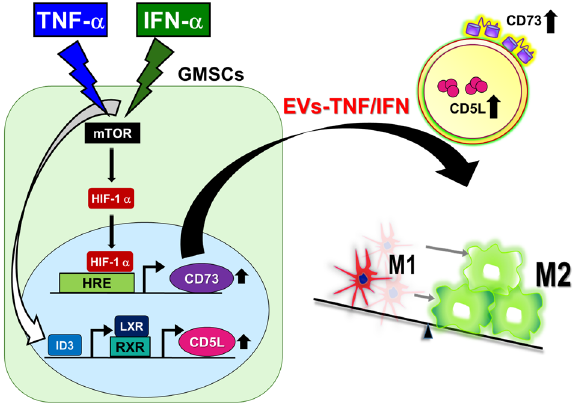
Figure 9. Proposed mechanism for enhancing EVs-mediated M2 macrophage polarization by dual TNF-α/ IFN-α preconditioning in GMSCs. EVs from GMSCs stimulated with TNF-α and IFN-α synergistically promote M2 macrophage polarization by upregulating exosomal CD73 and CD5L. Combined priming of TNF-α and IFN-α enhances the expression of CD73 through activation of the HIF-1α-mTOR pathway, and the upregulation of CD5L was transcriptionally mediated by LXR and ID3 in